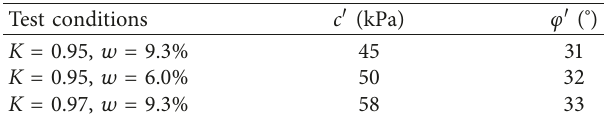
Table 3: Static shear strength properties of the soil under different test conditions.